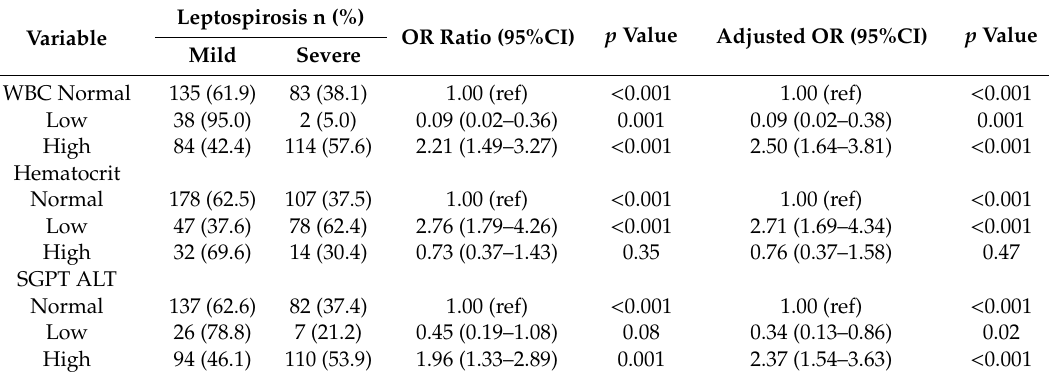
Table 4. Association between the laboratory results and severe leptospirosis.